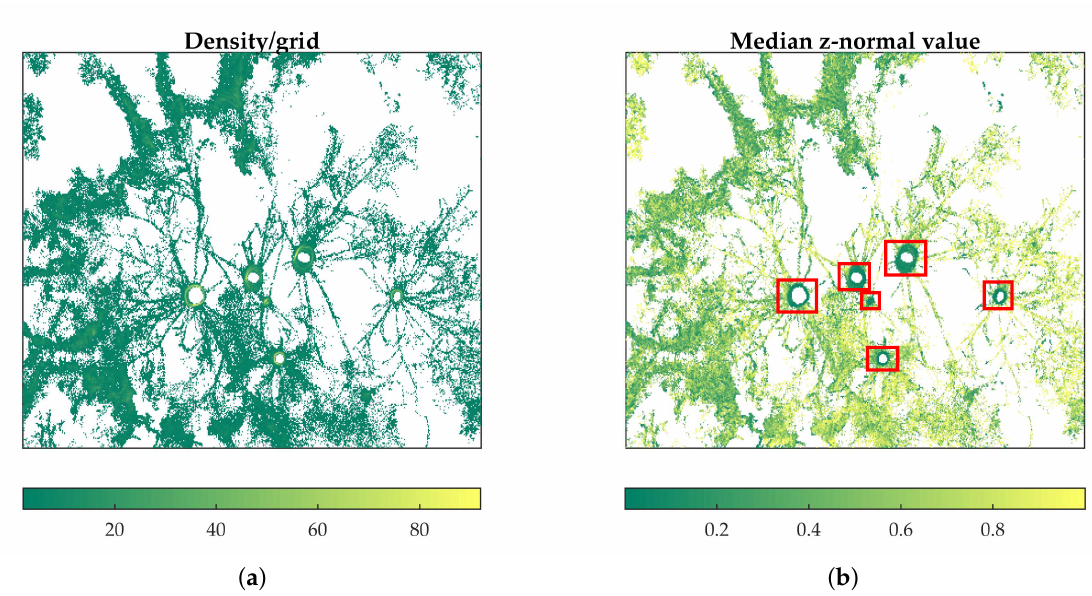
Figure 4. ( a ) An example of the projection density map of a point cloud subsection, which contains six trees. The map is generated by 2 cm × 2 cm grids. ( b ) Corresponding map of the average z-normal vectors. Red rectangles show six trees identified by our